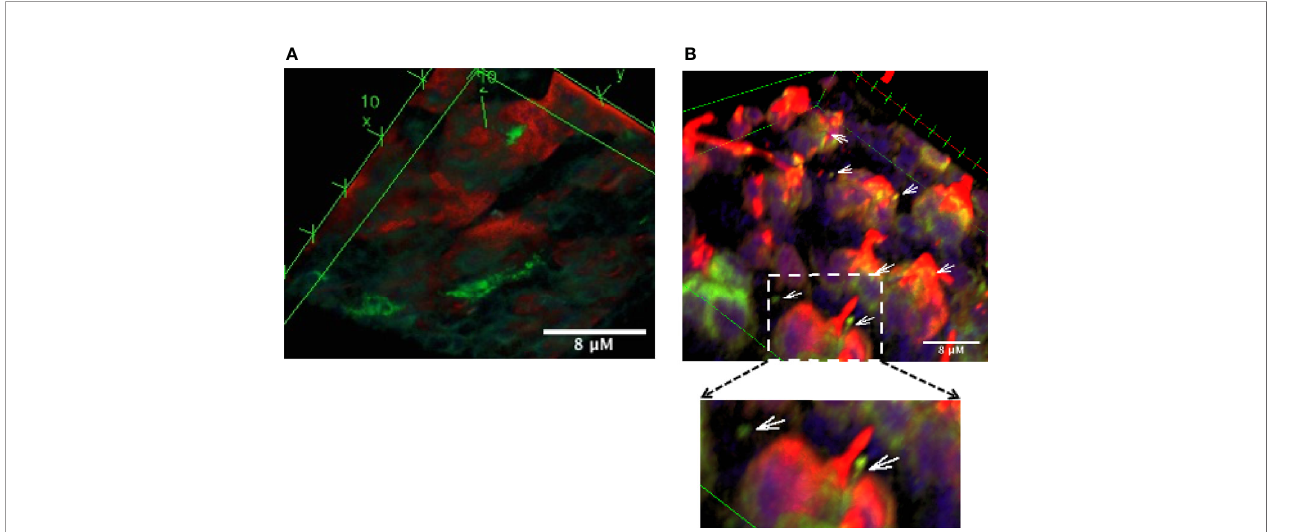
FIGURE 1 | Dendritic cells are located in close proximity of conjunctival goblet cells and extend trans-epithelial dendrites towards the ocular surface. Confocal microscopy images of the conjunctival explant from TSP-1 − / − mice with increased microbial frequency at the ocular surface. Tissue was stained for MUC5AC (red) to label GCs and CD11c (green) to label DCs. Images show three-dimensional view of 63 z-stack images captured using laser-scanning confocal microscope. (A) Bottom view of the explant shows sub-epithelial location of some DCs (green), (B) In the top view, extensions of DCs (arrows) and their proximity of GCs (red) can be observed. Digital magni fi cation of the boxed region in the top panel is shown to better illustrate DC extension with a globular tip protruding towards the ocular